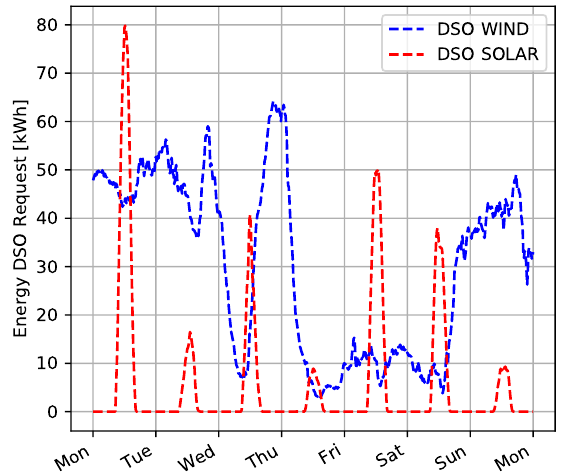
Figure 6. Total wind and solar energy production during a